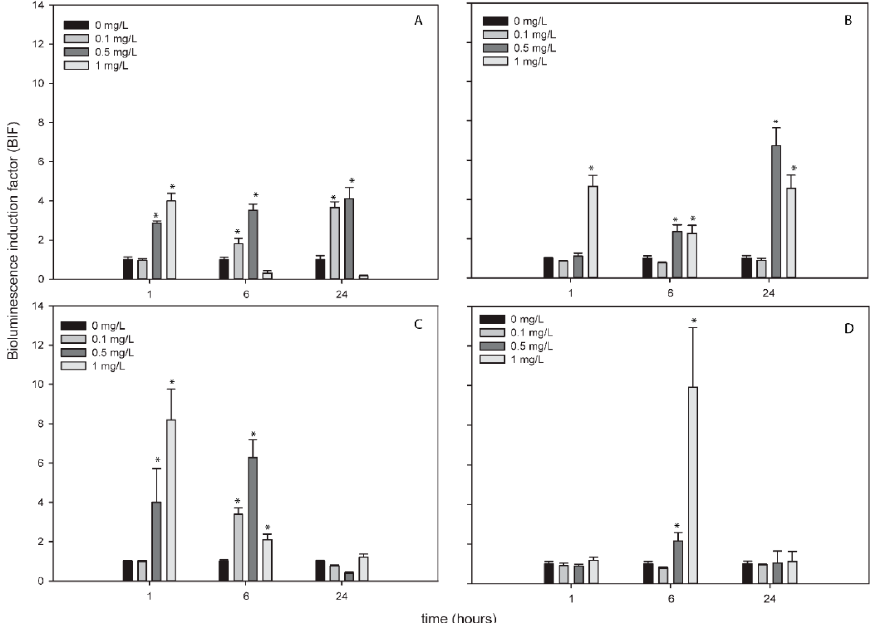
Figure 5 . Bioluminescence response of Nostoc sp. PCC7120 pBG2154 ( A , B ) and Nostoc sp.